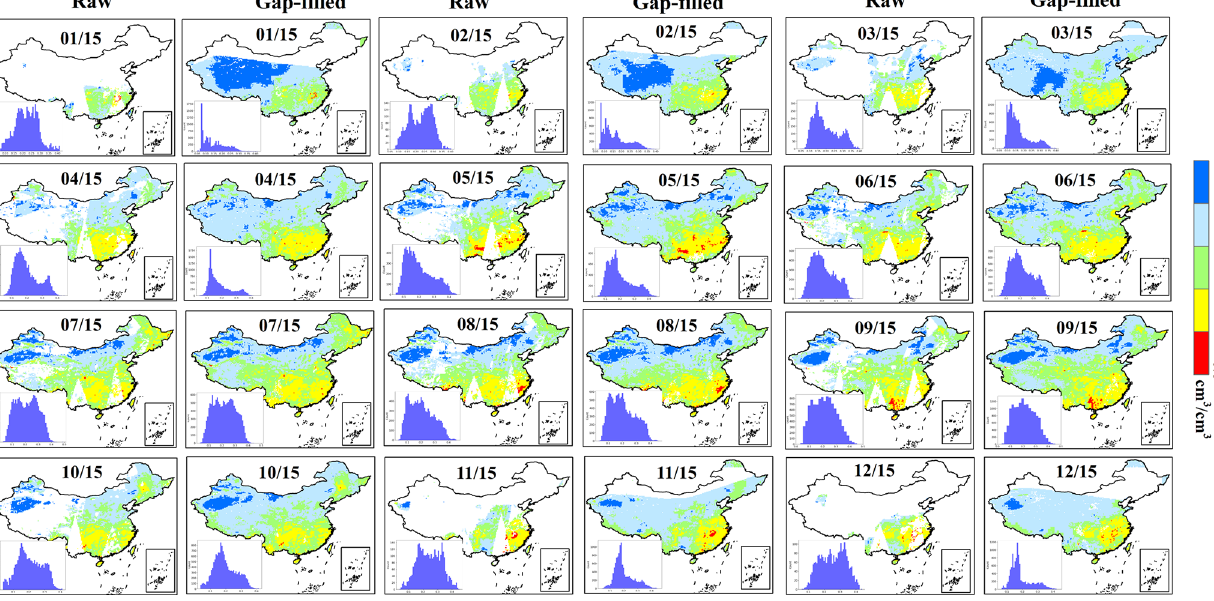
Figure 6. Spatial distributions and histogram of the raw and gap-filled CCI SM on the 15th of each month in 2009.